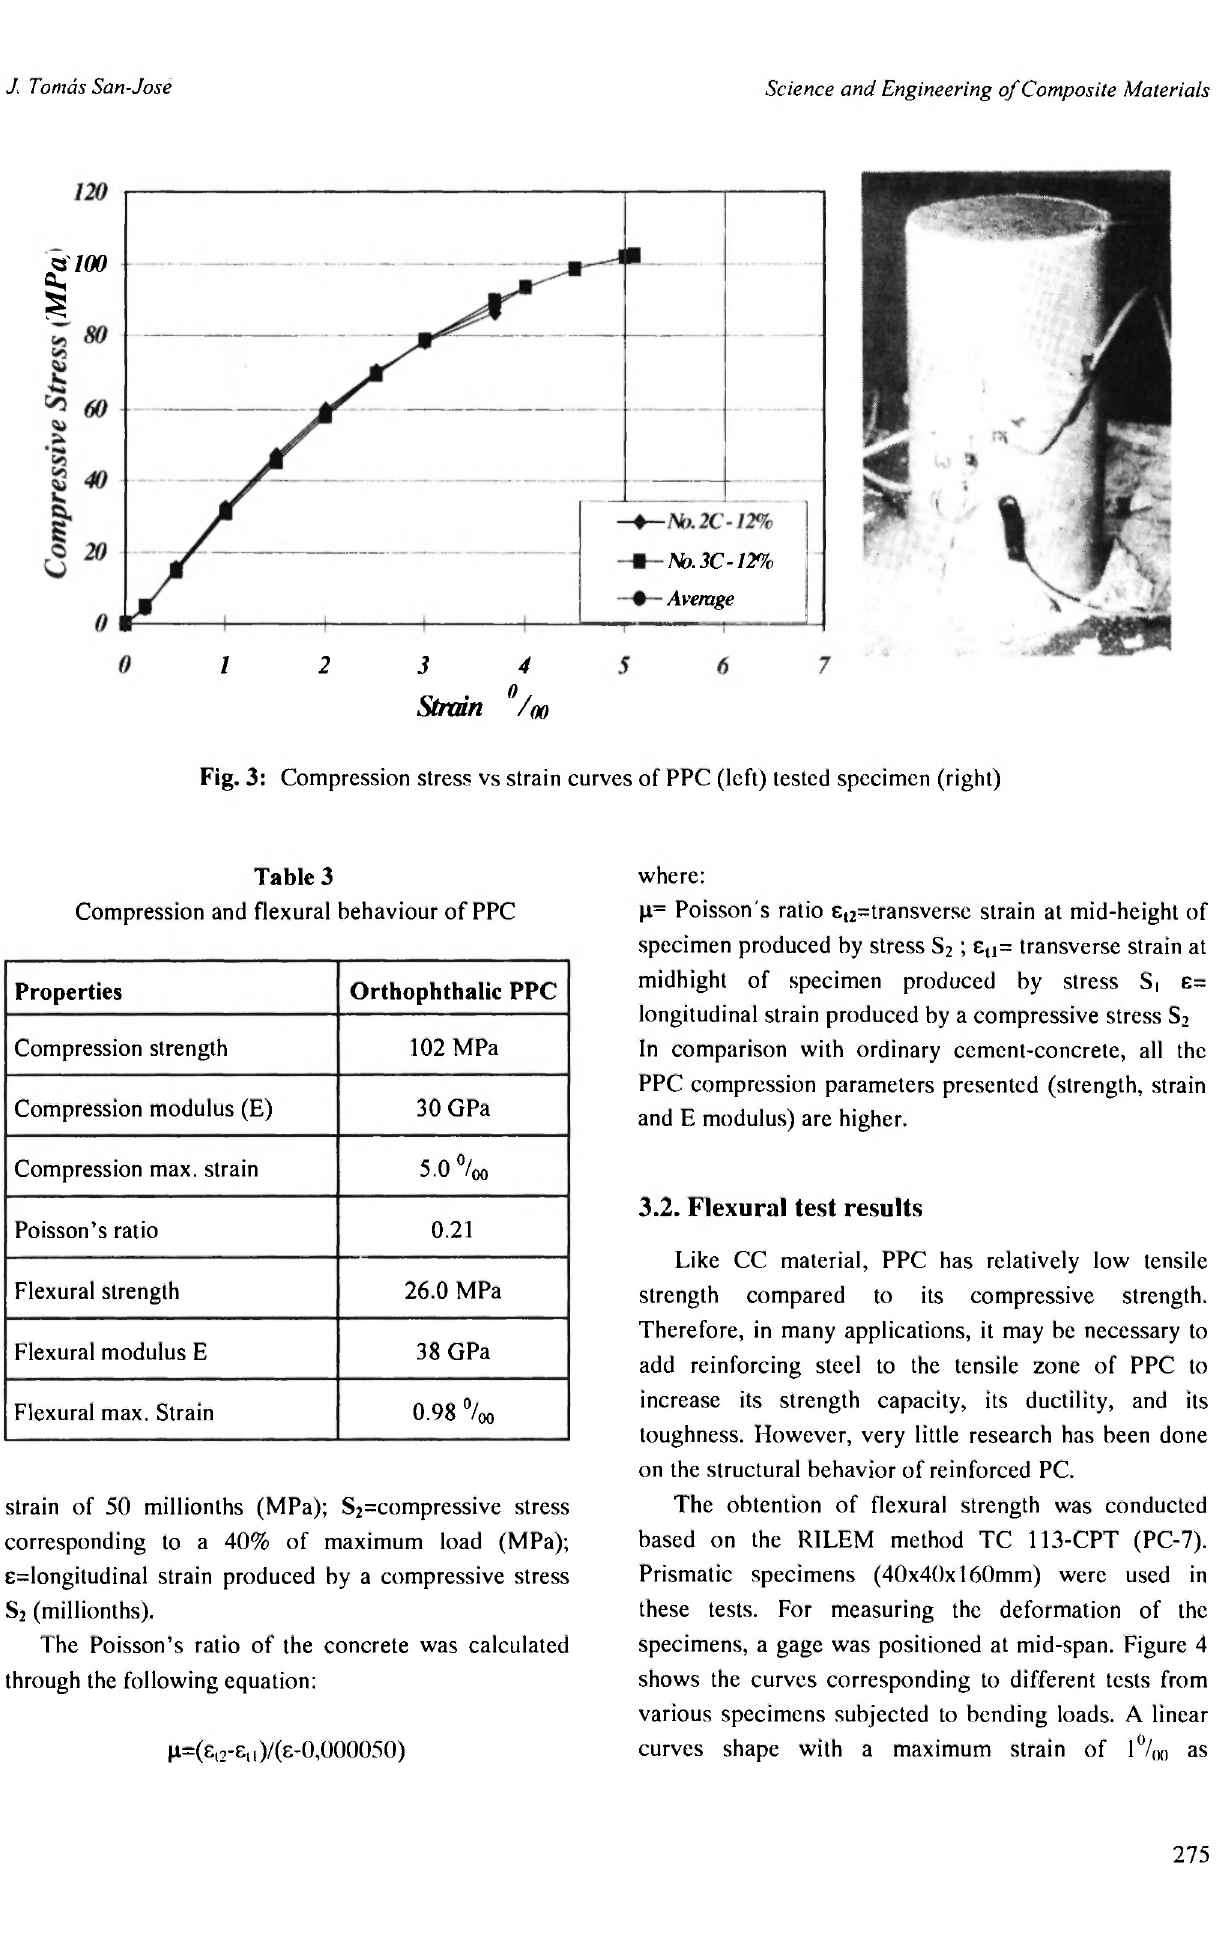
No.3C-12% Average 12 3 4 Strain °/oo Fig. 3: Compression stress vs strain curves of PPC (left) tested specimen (right)